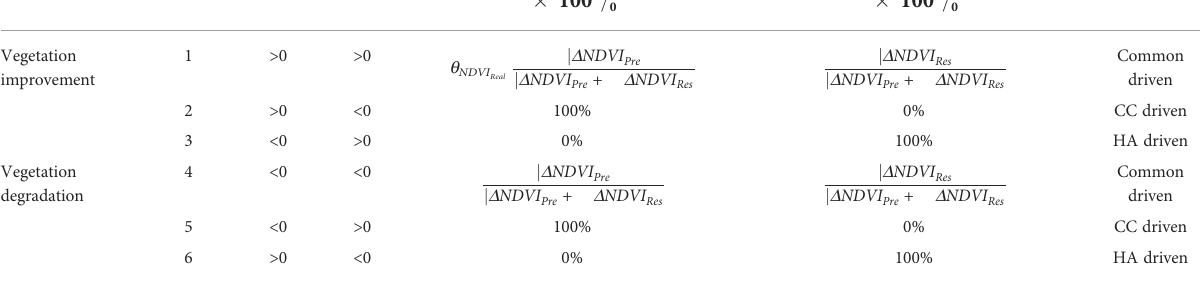
TABLE 3 Methods for evaluating the relative roles of climate change and human activities in the process of vegetation change under different scenarios. Zoning